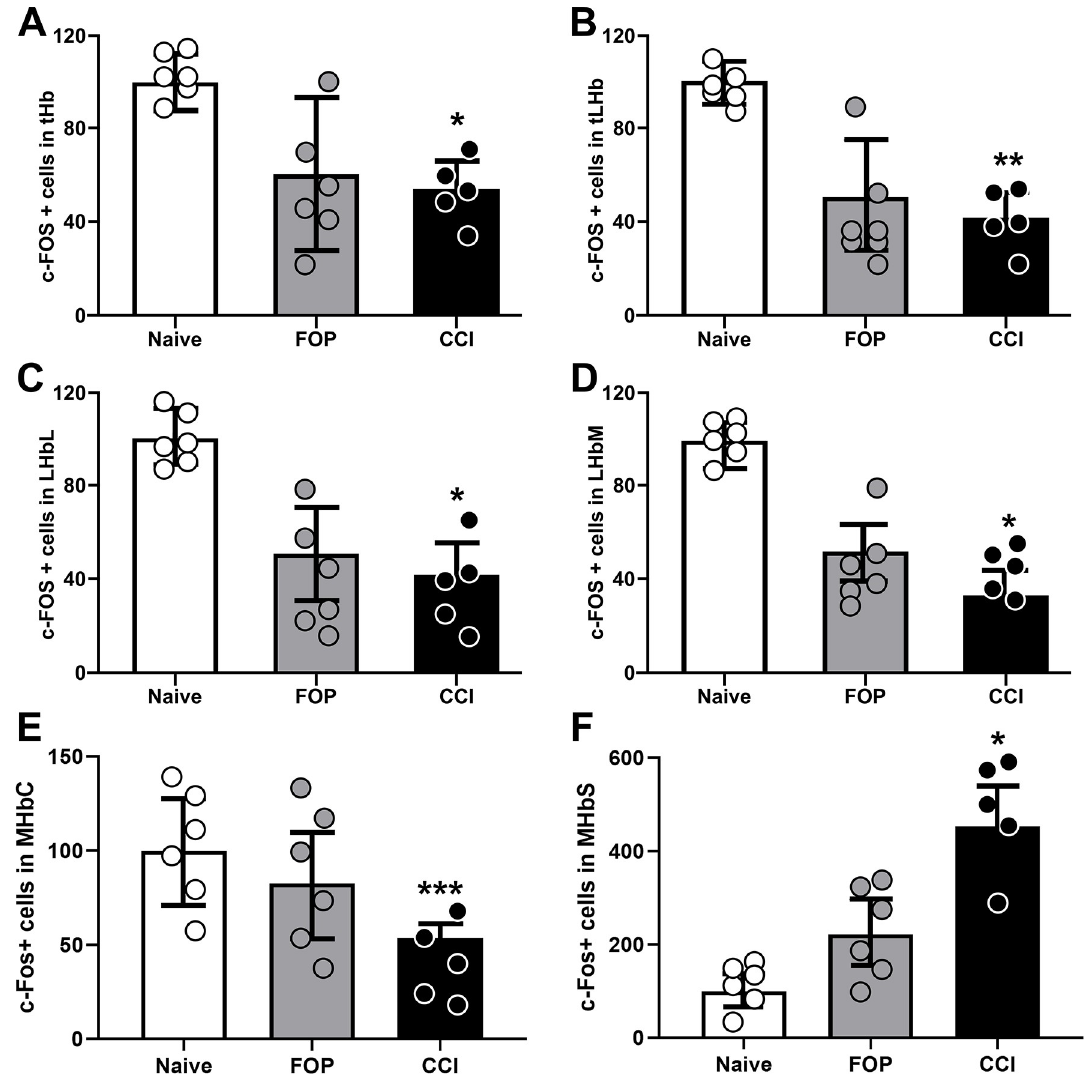
Fig 3. cFos immunoreactivity (cFos-IR) pattern in the habenula. A. Total Habenula (tHb) cFos-IR. B. Total Lateral Habenula (tLHb) cFos-IR. C. cFos-IR in the lateral subregion of the LHb (LHbL). D. cFos-IR in the medial subregion of the LHb (LHbM). E. cFos-IR in the central subregion of the medial habenula (MHbC). F. cFos-IR in the superior subregion of the medial habenula (MHbS). Abbreviations: FOP: false-operated group, CCI: chronic constriction injury group. Values are presented as normalized mean ± SEM. � p < 0.05, �� p < 0.01, ��� p <